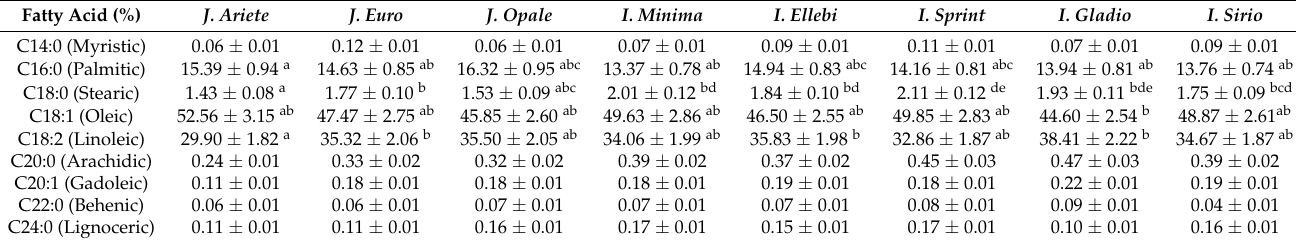
Table 3. Fatty acid composition (% ± SD of total fatty acids) from FAME GC-FID analysis of bran oils obtained from 8 rice varieties japonica and indica, from Portugal, obtained at 40 MPa, 313 K, and flow rate of 1.0